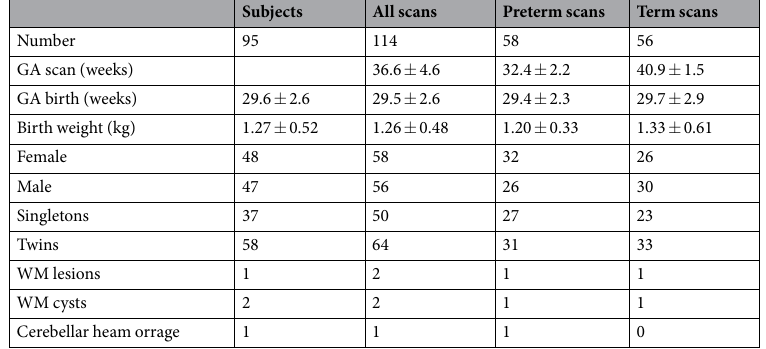
Table 2. Subjects and scans in the study. Some subjects had two or three scans. The first column refers to numbers and averages over all subjects. The other columns refer to numbers or averages over all scans, scans at preterm period (GA at scan between 27 and 37 weeks) and term equivalent age (GA at scan between 37 and 44 weeks).